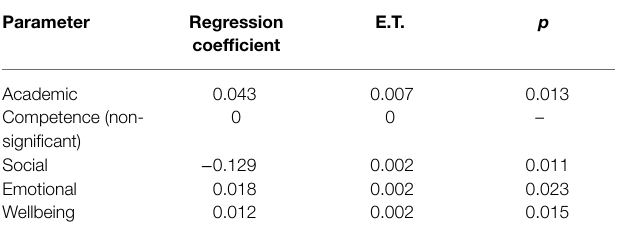
TABLE 5 | Results (regression coefficients and significant effects) for the fourth independent variable: perceived discomfort if no Internet connection is possible (Perceived_discomfort).